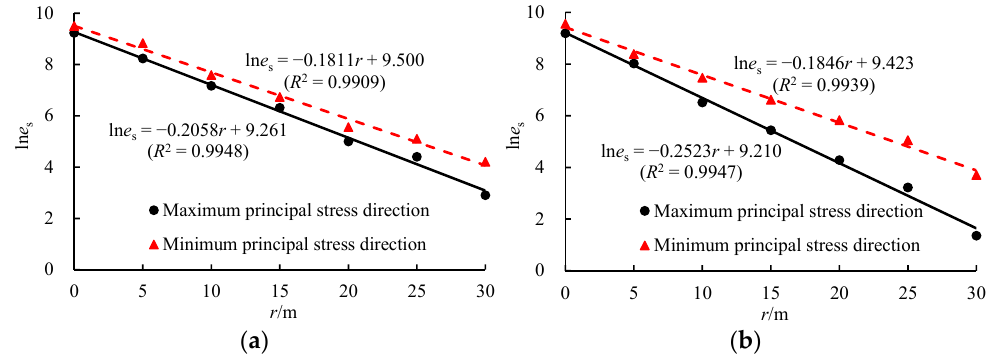
Figure 10. Regression analysis of seismic energy density attenuation with distance under non-hydrostatic in situ stress conditions: ( a ) σ x = 2 σ y = 20 MPa; ( b ) σ x = 3 σ y = 30 MPa.